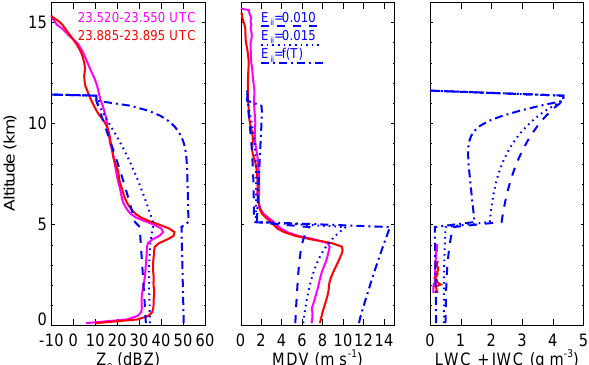
Figure 14. Profiles of Rayleigh-regime equivalent radar reflectivity factor ( Z e , left), mean Doppler velocity (MDV, center), and total hy- drometeor condensed water content LWC + IWC (right) observed in stratiform region of mesoscale convective system during TWP- ICE through two different periods, labeled with times as decimal day of year UTC (magenta and red solid lines), and from steady- state column simulations using sticking efficiencies for collisions between fluffy ice particles of 0.01 (blue dashed lines), 0.015 (blue dotted lines), and exp ( 0 . 09 T C ) with T C air temperature in ◦ C (blue dash-dotted line). Details provided in